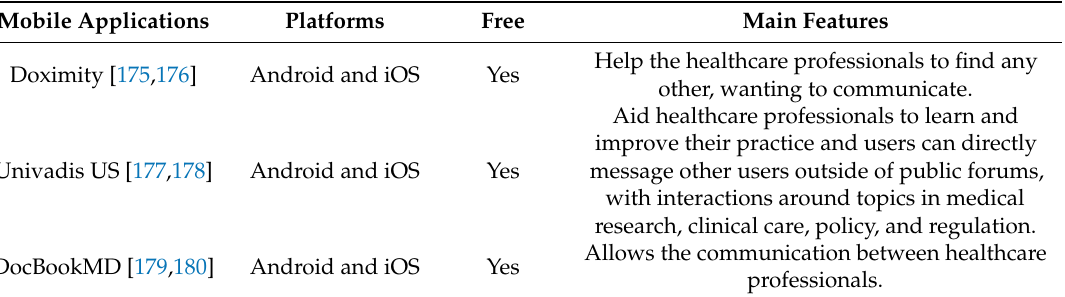
Table 8. Mobile health applications related to social